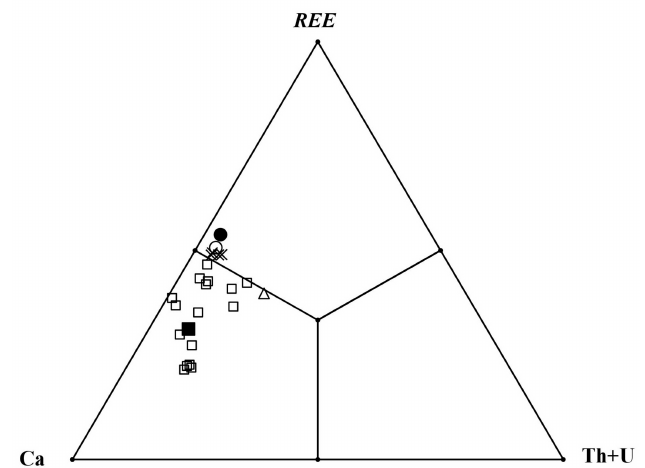
Figure 6. Ratios of large cations with coordination number 8 in zirconolite-type minerals from the Laach Lake volcano: the holotype ( ) and cotype ( ) nöggerathite-(Ce), other nöggerathite-(Ce) samples ( × ), (cid:35) the stefanweissite holotype ( (cid:4) ), other stefanweissite samples ( (cid:3) ), and the holotype laachite ( ∆